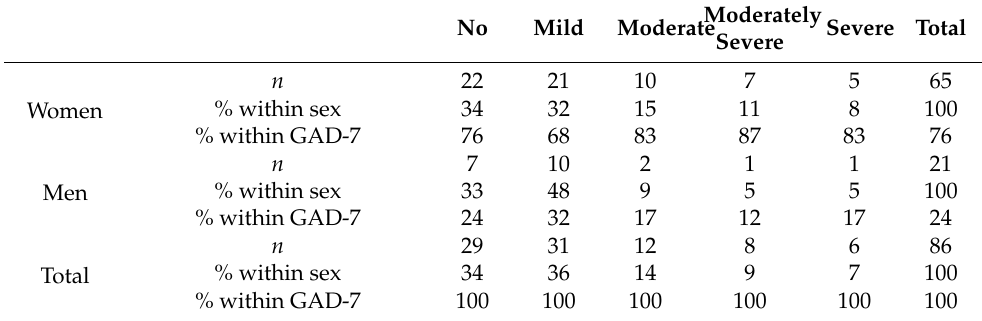
Table 2. Patient Health Questionnaire (PHQ-9) scores according to sex of the studied population.